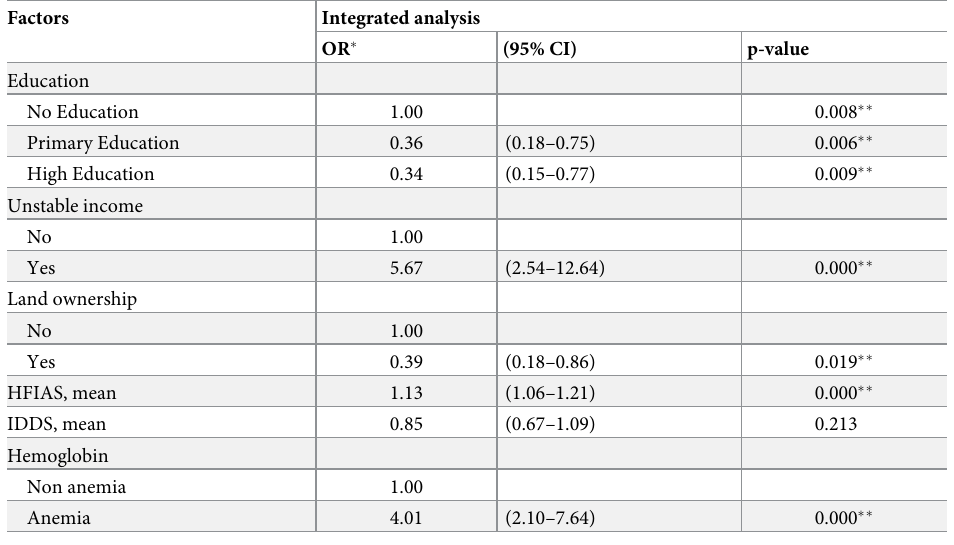
Table 5. Integrated logistic regression analysis consisting of significant and relevant